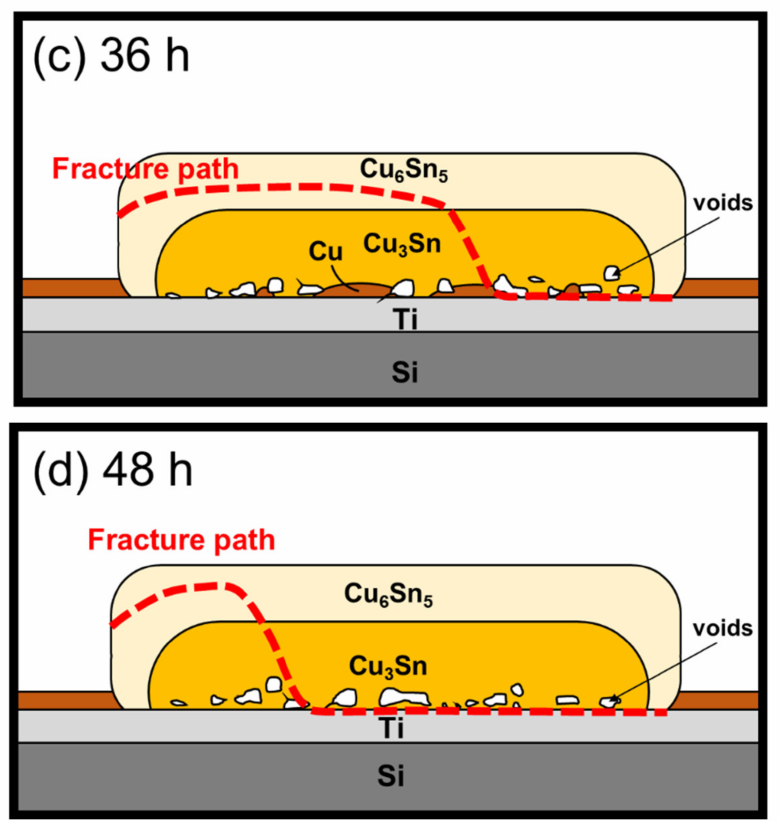
Figure 13. Schematic drawing showing the crack propagation of Sn/Cu micro-bumps ( a ) as-fabricated, and after ( b ) 24 h, ( c ) 36 h, and ( d ) 48 h of